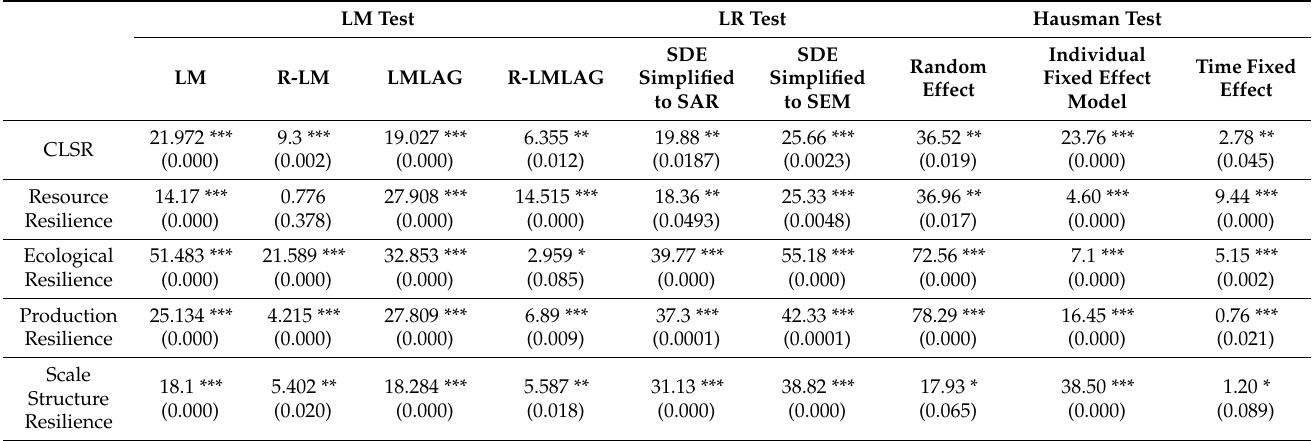
Table 4. LM, R-LM, and Hausman test